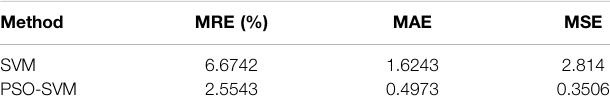
TABLE 2 | Comparison of two method for battery #2.